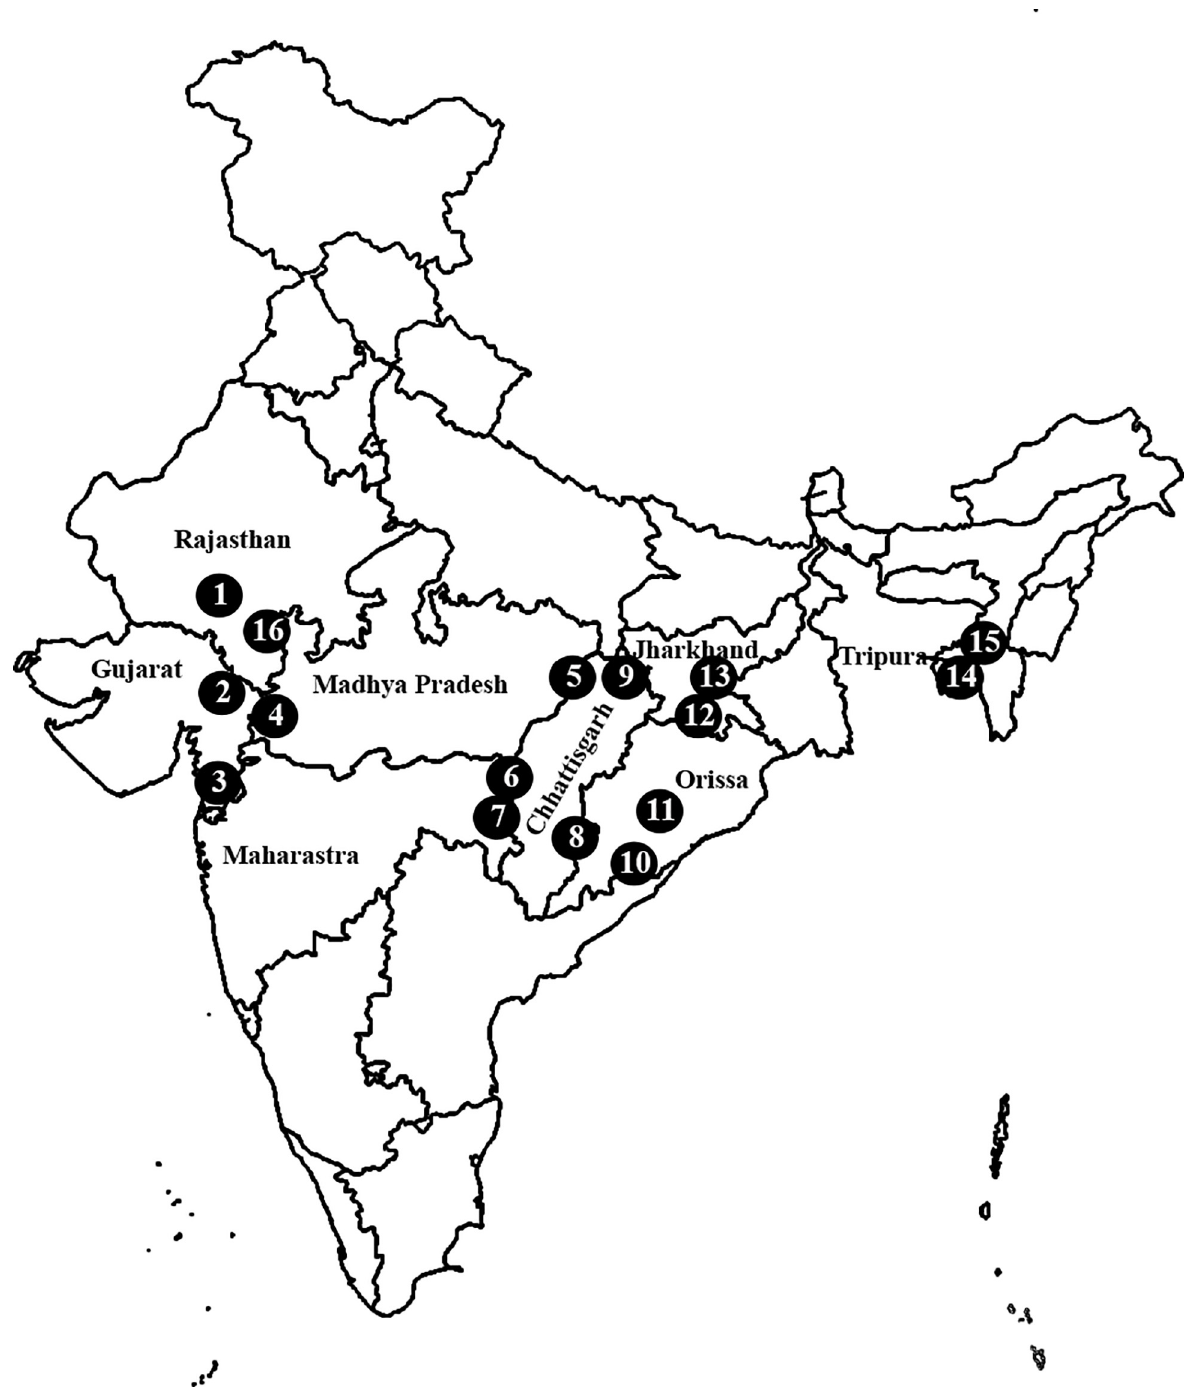
Fig 1. Map showing the study sites from eight malaria endemic states of India. Each state has two study sites.